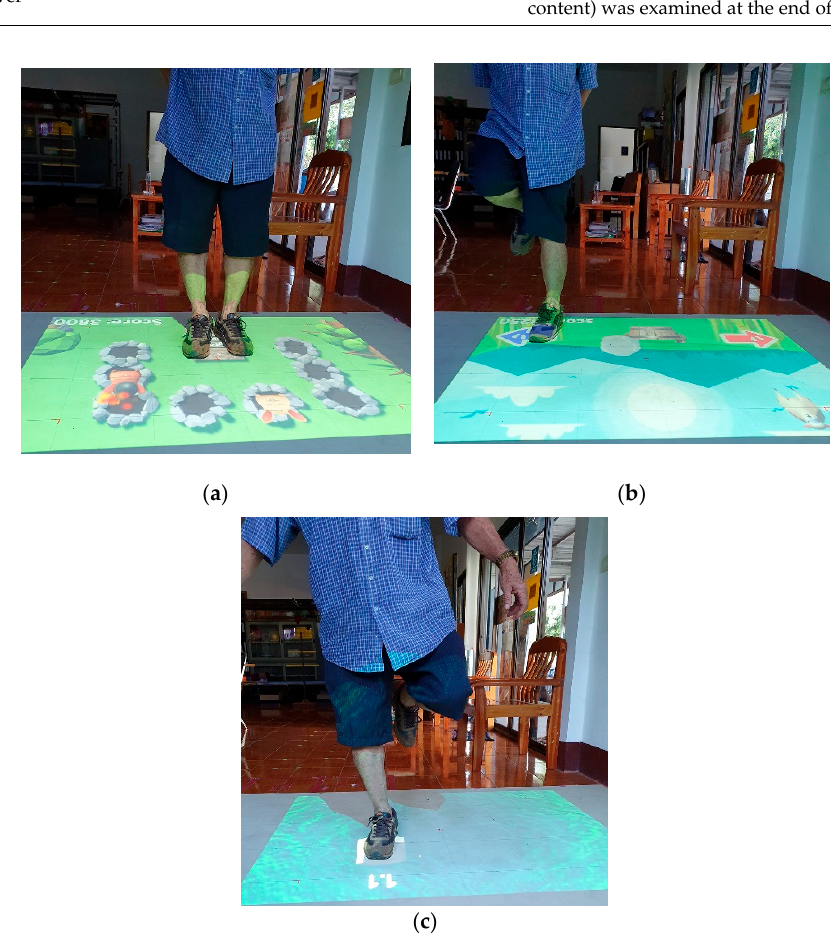
Figure 2. Example of the interactive physical-cognitive game-based training program: ( a ) Whack a mole game; ( b ) Sky fall game; ( c ) Crossing poison river game.